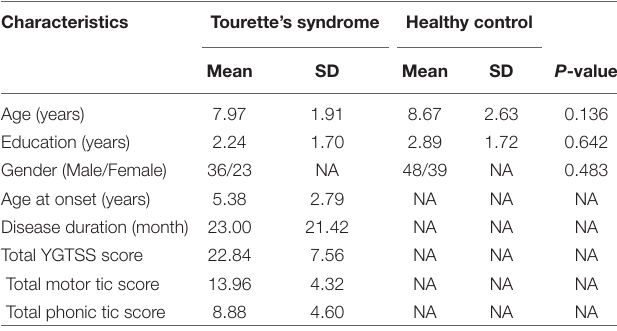
TABLE 1 | Demographic characteristics of patients with Tourette’s syndrome (TS) and healthy controls (HCs). Characteristics